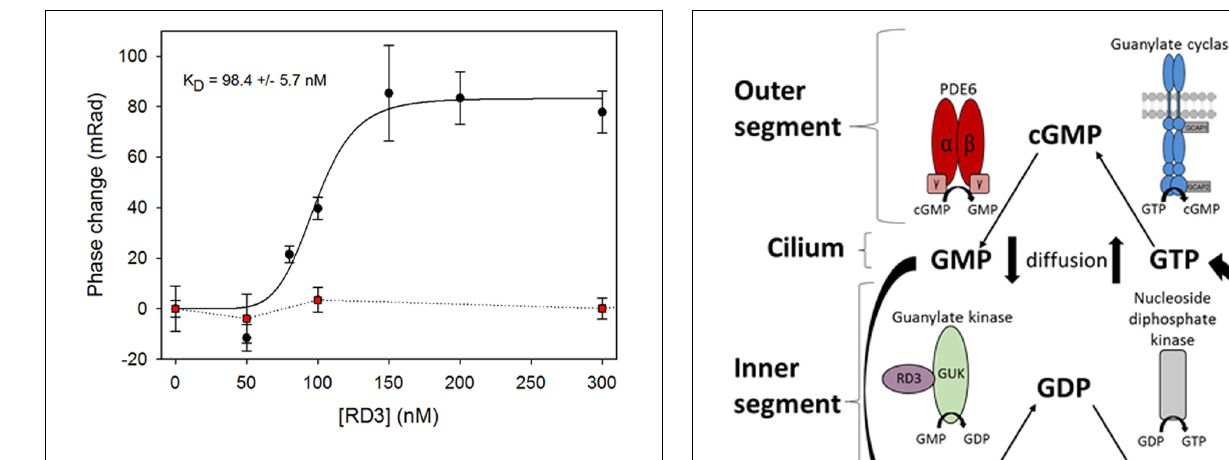
FIGURE 6 | RD3 and GUK interaction detected by Back Scattering Interferometry (BSI). Various RD3 concentrations ranging from 0 to 300 nM were tested for interaction with GUK (black dots) by BSI. Titration of a control protein (TEV) to GUK showed no binding (red squares). Titration series is an example of three independent experiments. Each symbol is the mean ± SD of five data points. Curve fitting was performed with SigmaPlot 13 using a normal Hill equation.